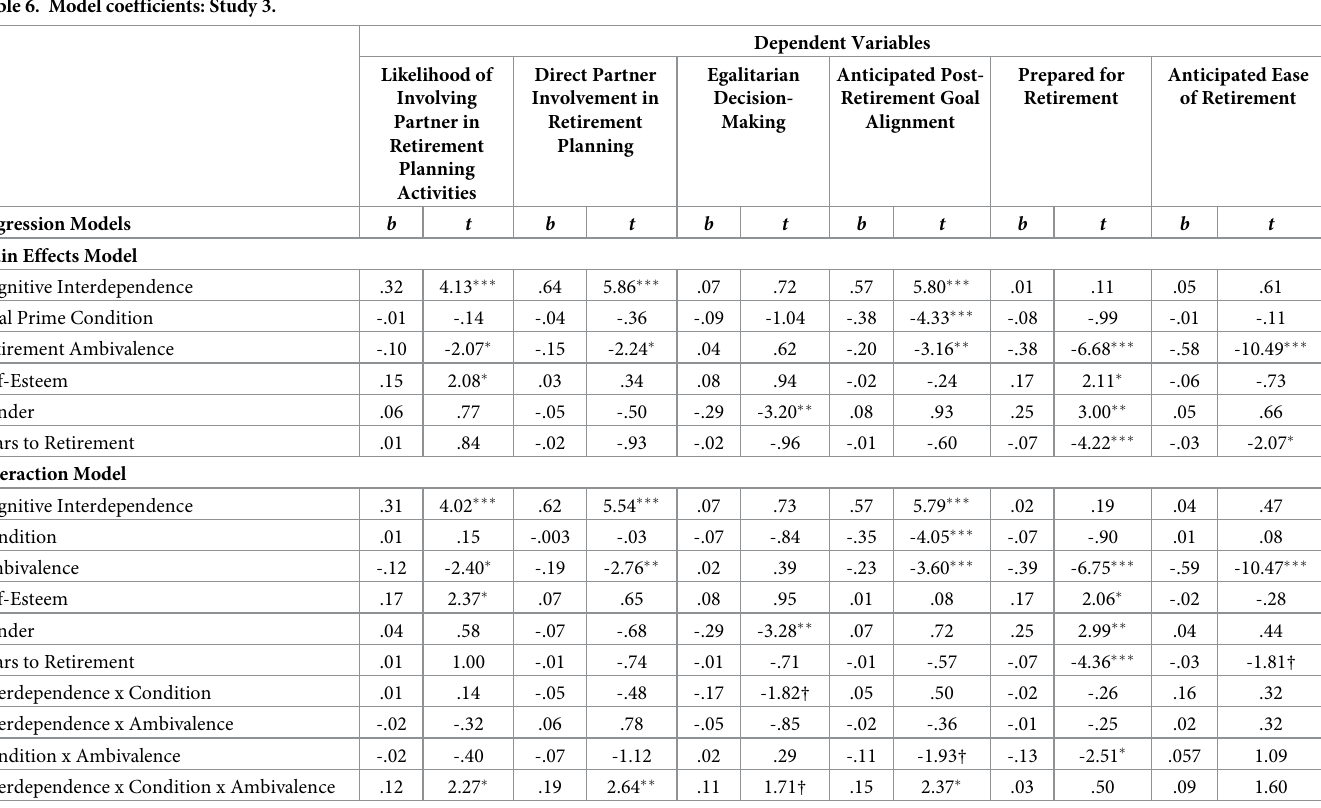
Table 6. Model coefficients: Study